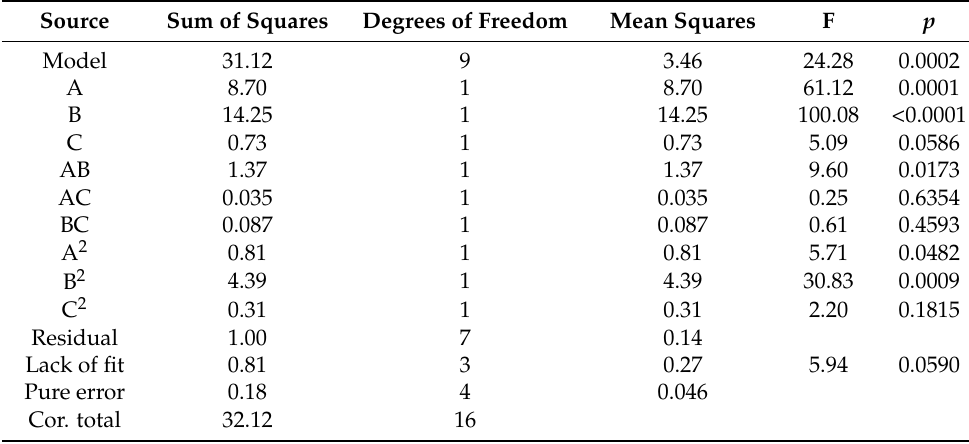
Table 2. ANOVA for response surface